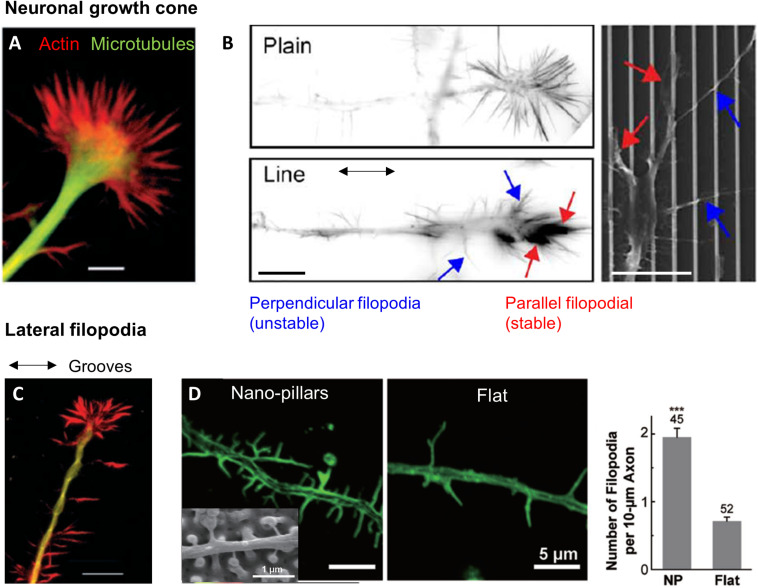
Topography sensing in neuronal cells. (A) Structure of a neuronal growth cone (GC). Scale 5 μm. Reproduced with permission from Rajnicek and McCaig (1997). (B) Growth cone filopodia on flat or grooved substrate. GC on grooves show two population of filopodia: parallel or perpendicular. Scale 10 μm. From Jang et al. (2010). (C) Lateral filopodia along grooves from the neurite shaft on perpendicularly oriented neurites. Scale 10 μm. Reproduced with permission from Rajnicek and McCaig (1997). (D) Increased number of lateral filopodia on hippocampal neurites on nano-pillars. Reproduced with permission from Seo et al. (2018). The *** correspond to the p-value of the t-test in between the 2 groups ***p < 0.001.